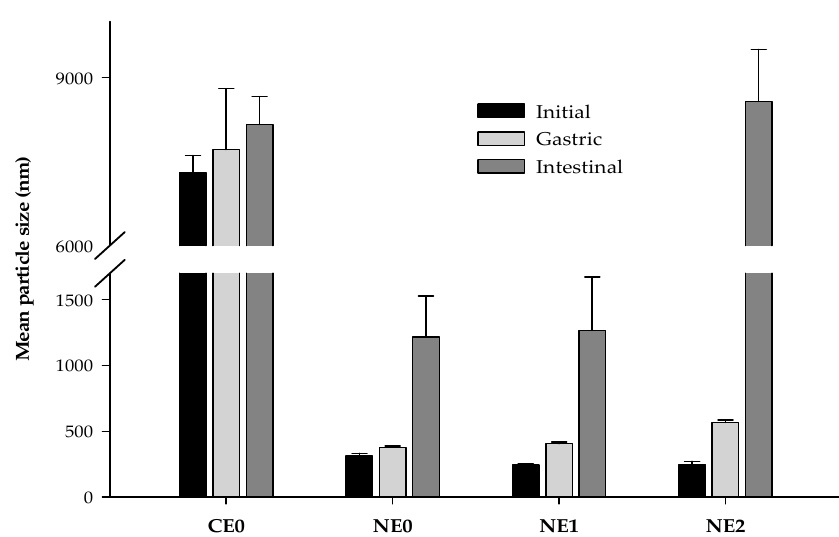
Figure 5. Mean particle size values ( d 32 ) of coarse emulsion and nanoemulsions with different pectin concentrations (0%, 1%, and 2%) at different phases of the in vitro digestion. CE0, coarse emulsion without pectin; NE0, nanoemulsion without pectin; NE1, nanoemulsion with 1% of pectin; NE2, nanoemulsion with 2% of pectin.